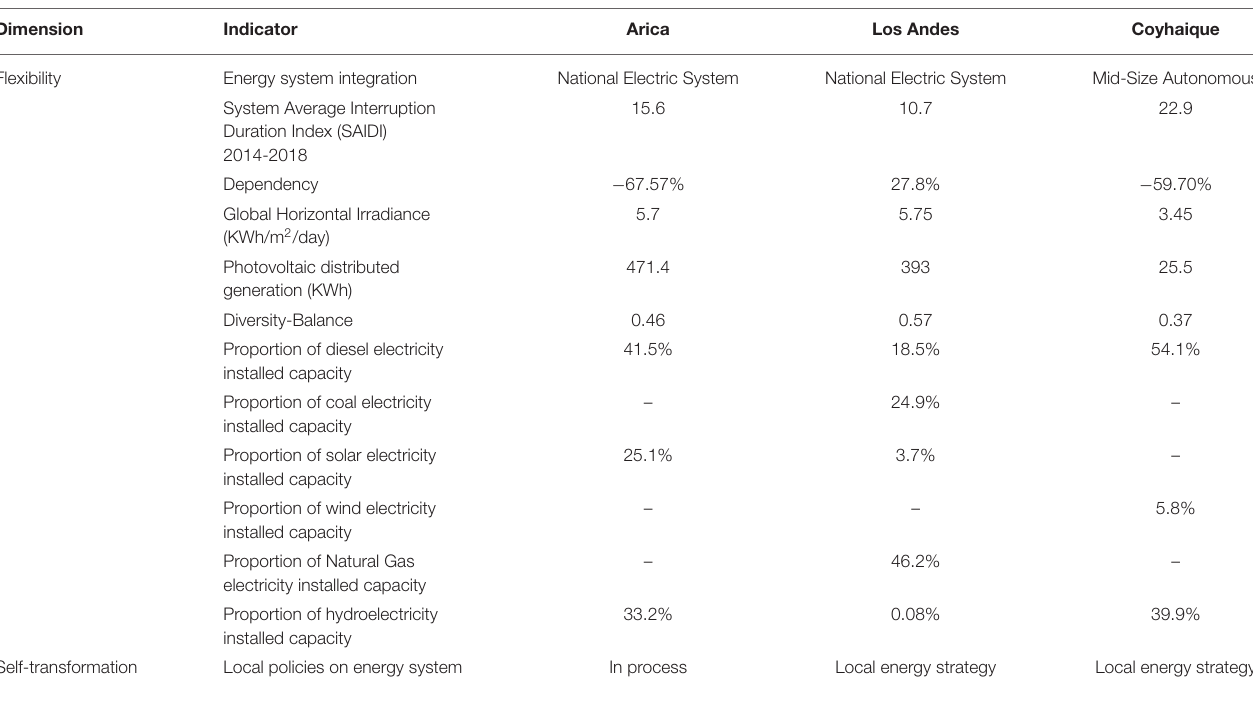
TABLE 5 | Case study resilience indicators. Dimension